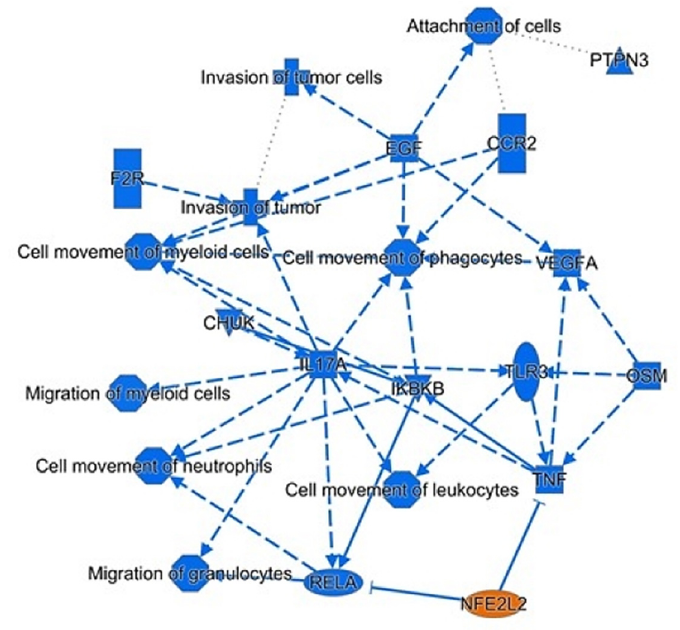
Figure 3. Graphical summary of IPA core analysis of differentially expressed proteins between Caki-1 and Caki-2 cells. The overview highlights the major biological themes in these analyses and their relationships connecting some of the most significant components predicted in the analysis. In this analysis, NRF2 (NFE2L2) is predicted to be significantly activated in Caki-2 cells (brown color). The major targets that are inhibited include TNF, RELA, and IKBKB. The result is the inhibition of multiple pathways that are associated with carcinogenesis.